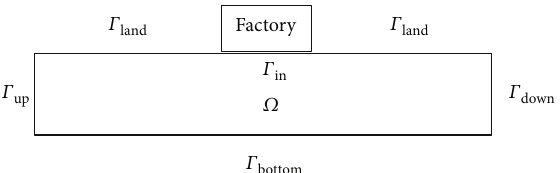
Figure 7: Domain for the pollute transport problem.